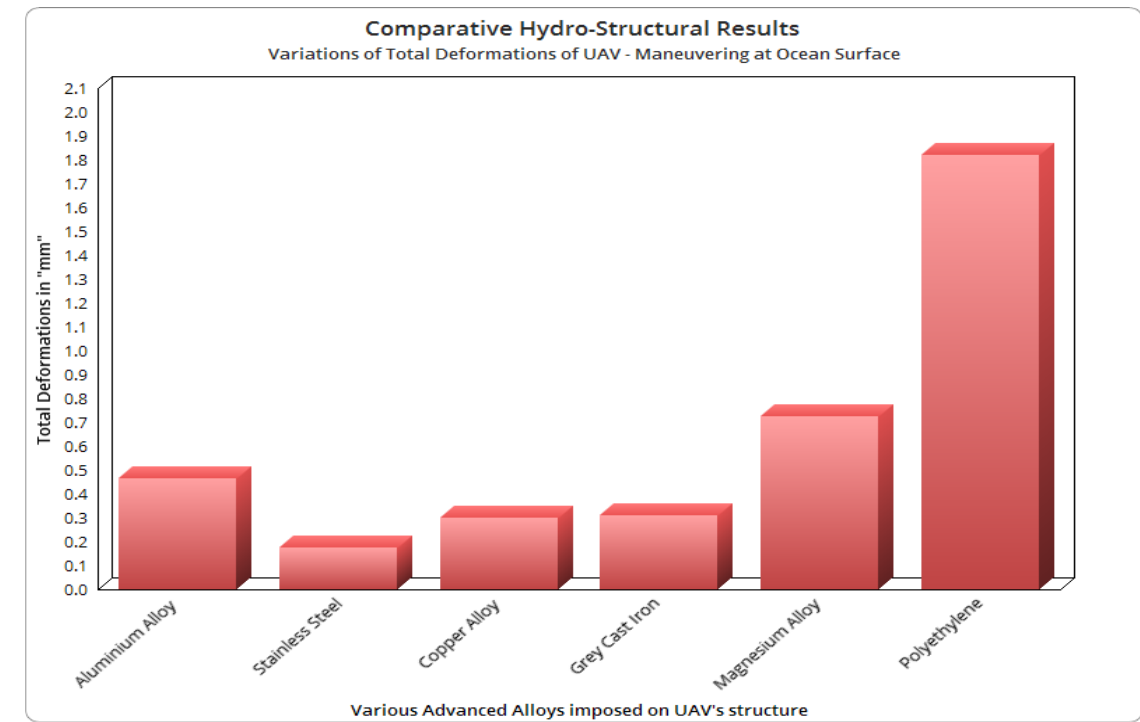
Figure 27. Variations of total deformations of different alloys.